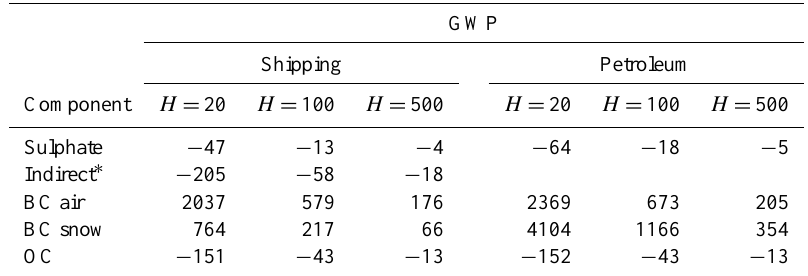
Fig. 6. Contribution to tropospheric column of sulphate [µgm − 2 ] from (a) shipping and (b) petroleum in winter (January-February-March) and (c) shipping and (d) petroleum activity in summer (July-September-August) (note that the figures for shipping and petroleum have different color scales). Table 4. GWP values for shipping and petroleum emissions (global mean) for 20, 100 and 500yr time horizons. Sulphate is calculated on SO 2 basis (not S-basis)